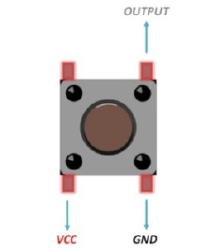
Fig. 10. Pinout of push